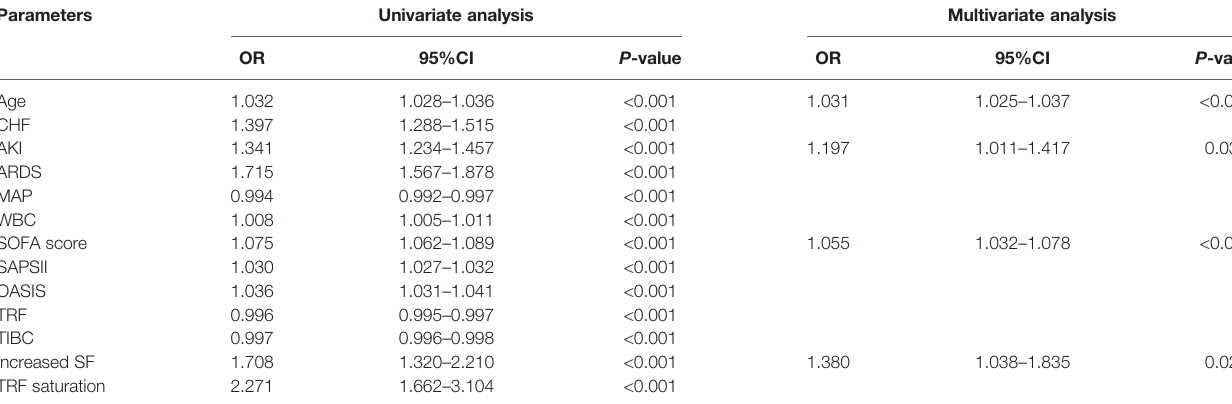
TABLE 3 | Cox regression analysis for all-cause death in critically ill patients with diabetes.